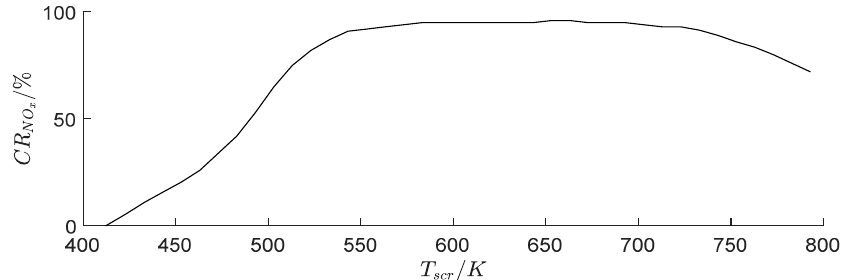
Figure 6. Effect of the temperature on the conversion efficiency of the SCR system.